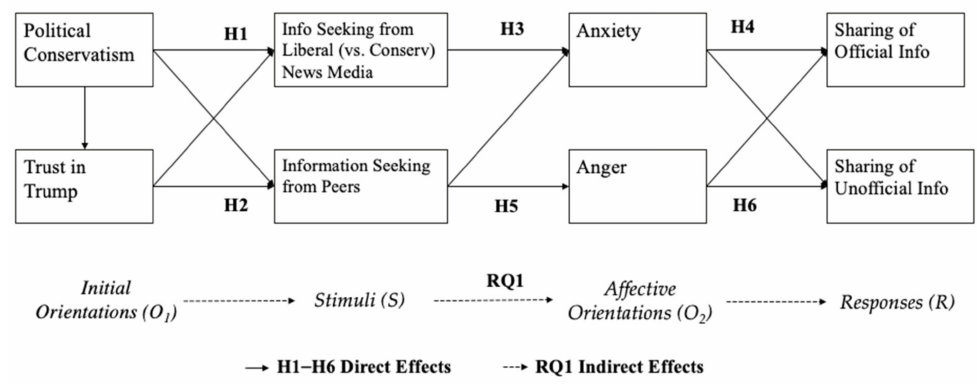
Figure 1. Theoretical model (O 1 -S-O 2